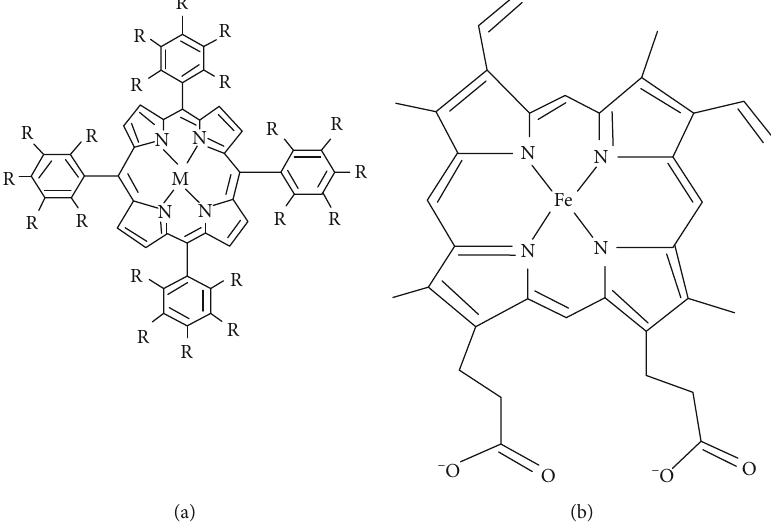
Figure 2: (a) Metalloporphyrin with central symbol “ M ” for any metal. (b) Heme with central symbol “ Fe ” for